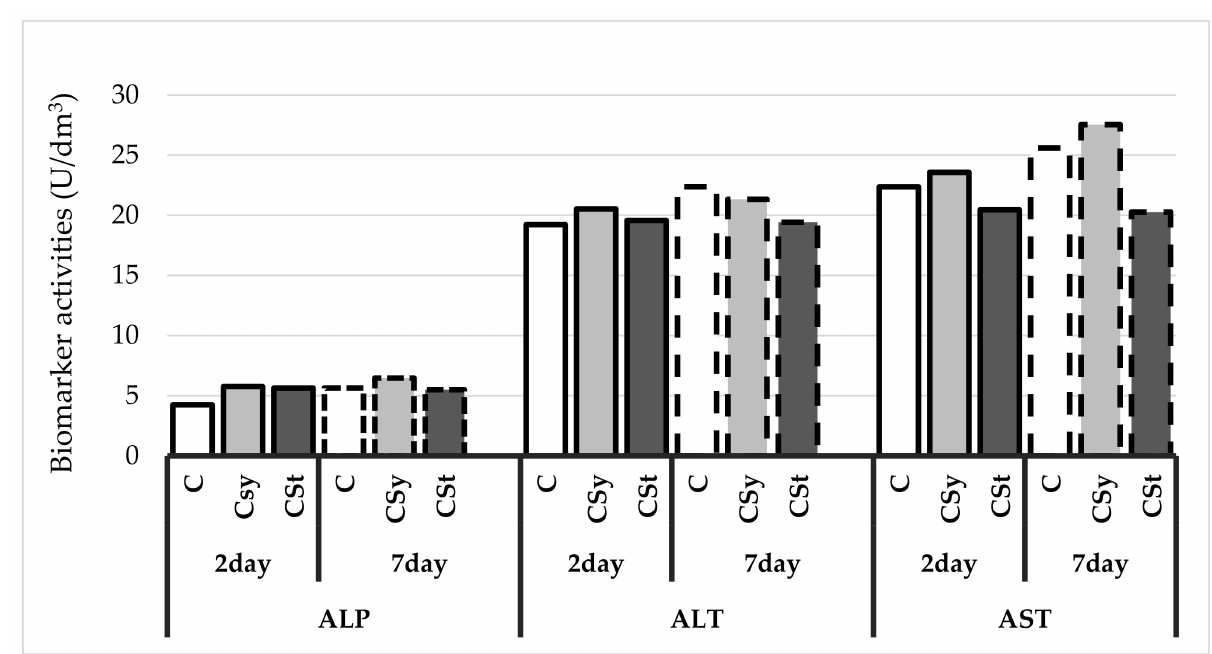
Figure 4. Biomarker activities in the 2- and 7-day-old honey bees’ hemolymph after two methods of supplementation with hemp extract: C–control (pure sugar syrup), Csy–hemp extract in syrup, Cst–hemp extract on strips. (Two-Way ANOVA: ALT (alanine aminotransferase): supplementation method: F (2,59) = 163.68, p = 0.000; days of supplementation: F (1,59) = 321.14, p = 0.000; supplementation method*days of supplementation F (2,59) = 205.18, p = 0,11089, AST (aspartate aminotransferase): supplementation method: F (2,59) = 1180.7, p = 0.000; days of supplementation: F (1,59) = 719.49, p = 0.000; supplementation method*days of supplementation F (2,59) = 206.94, p = 0.000, ALP (alkaline phosphatase): supplementation method: F (2,59) = 204.58, p = 0.000; days of supplementation: F (1,59) = 185.72, p = 0.000; supplementation method*days of supplementation F (2,59) = 87.550, p = 0.000).